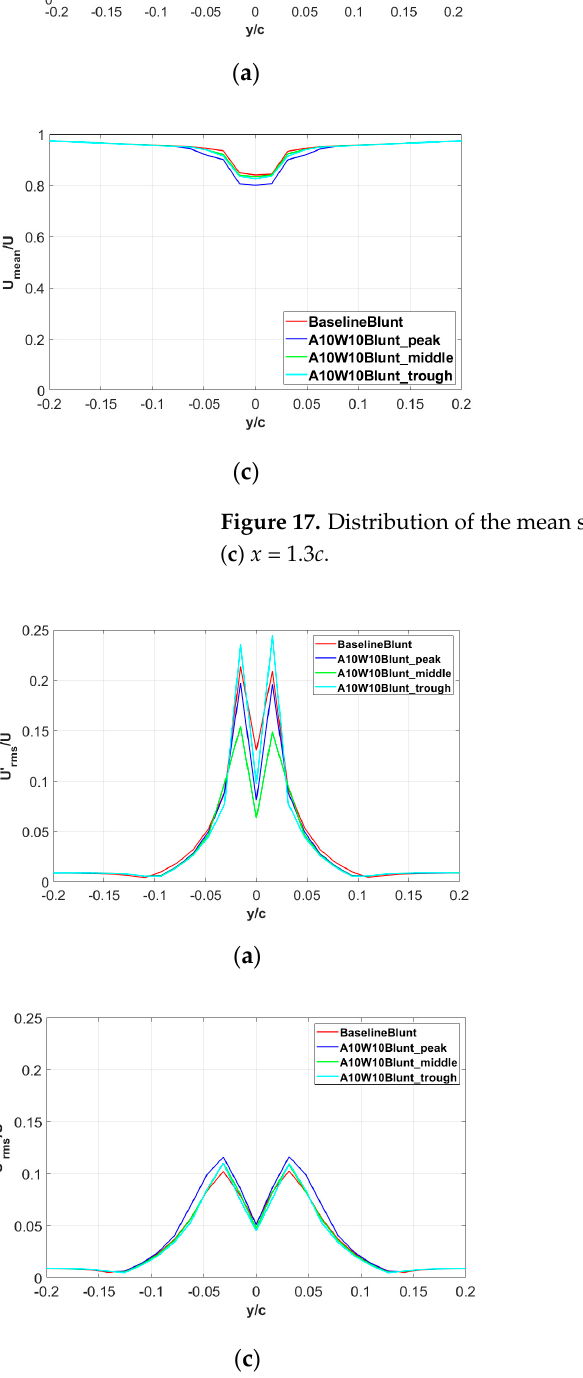
Figure 18. Distribution of the fluctuating streamwise velocity in the wake region: ( a ) x = 1.1 c ; ( b ) x = 1.2 c ; ( c ) x = 1.3 c .